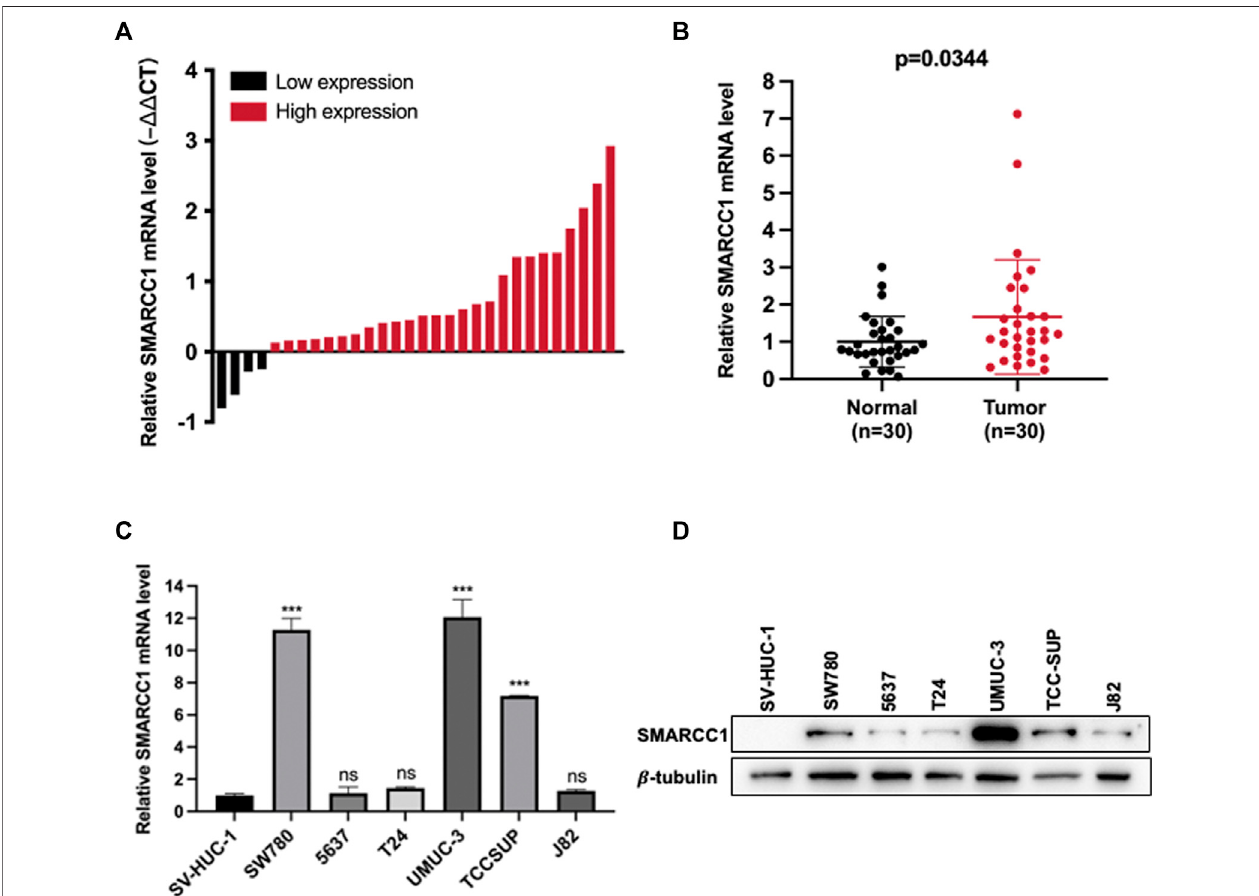
FIGURE 2 | SMARCC1 was highly expressed in BC tissues and cell lines. (A) SMARCC1 was highly expressed in 86.7% (26/30) of the BC specimens compared with para-cancerous tissues. (B) The relative expression of SMARCC1 in BC tissues was signi fi cantly higher than that in adjacent normal tissues. The mean of each triplicate result was used to calculate the relative SMARCC1 concentration by using the comparative 2- Δ Ct method. (C) The mRNA level of SMARCC1 in BC cell lines wasevaluated by RT-qPCR. The mRNA level ofSMARCC1 in SW780, UMUC-3, and TCCSUPcells washigher than that in SV-HUC-1 cells. GAPDH wasused as thecontrol. (D) TheproteinlevelofSMARCC1inBCcelllineswasmeasuredbywesternblot.ComparedwithSV-HUC-1cellline,theBCcelllines(SW780,UMUC-3and TCCSUP) exhibited relatively high protein levels of SMARCC1. β -tubulin was used as the endogenous control. * p < 0.05, ** p < 0.01, *** p <